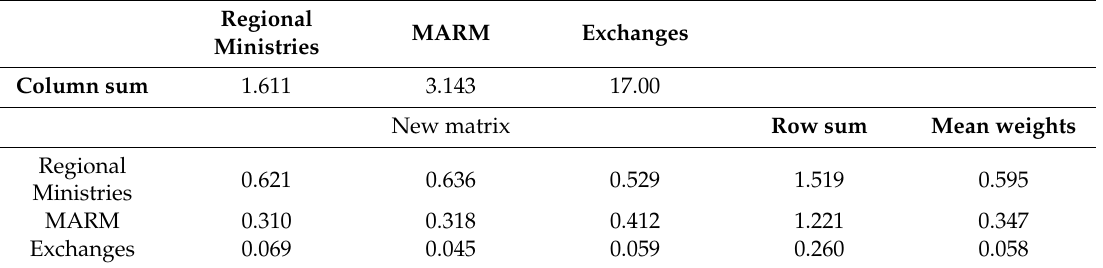
Table 9. Calculation of the weighting of each source of